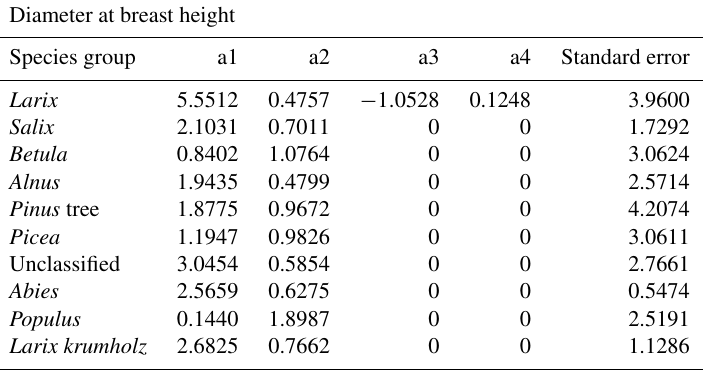
Table C2. Coefficients for diameter at breast height